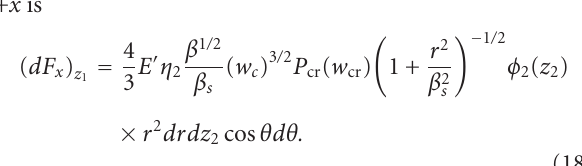
unit nominal area on S 2 . The component of this force along + x